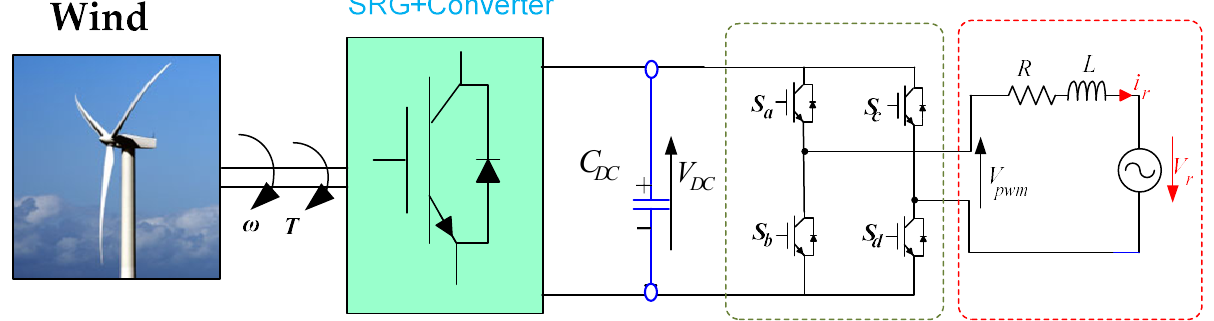
Figure 20. Complete system of SRG connected to single-phase network.